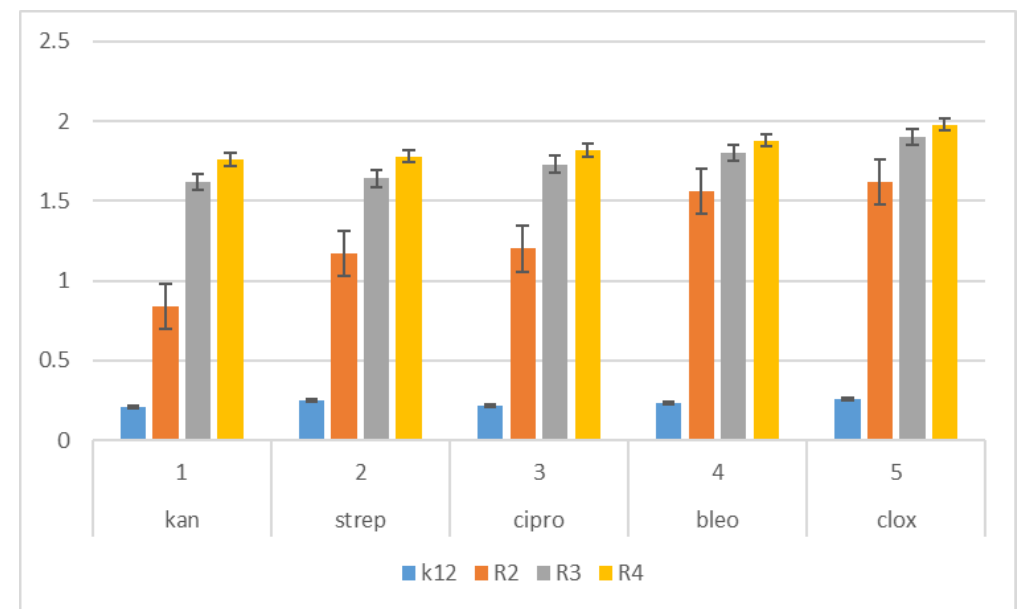
Figure 7. Examples of MIC with model bacterial strains K12, R2, R3, and R4 of the studied antibiotics with kanamycin, streptomycin, ciprofloxacin, bleomycin and cloxacillin. The x -axis features antibiotics that were used sequentially. The y -axis features the MIC value in µg/mL −1 .